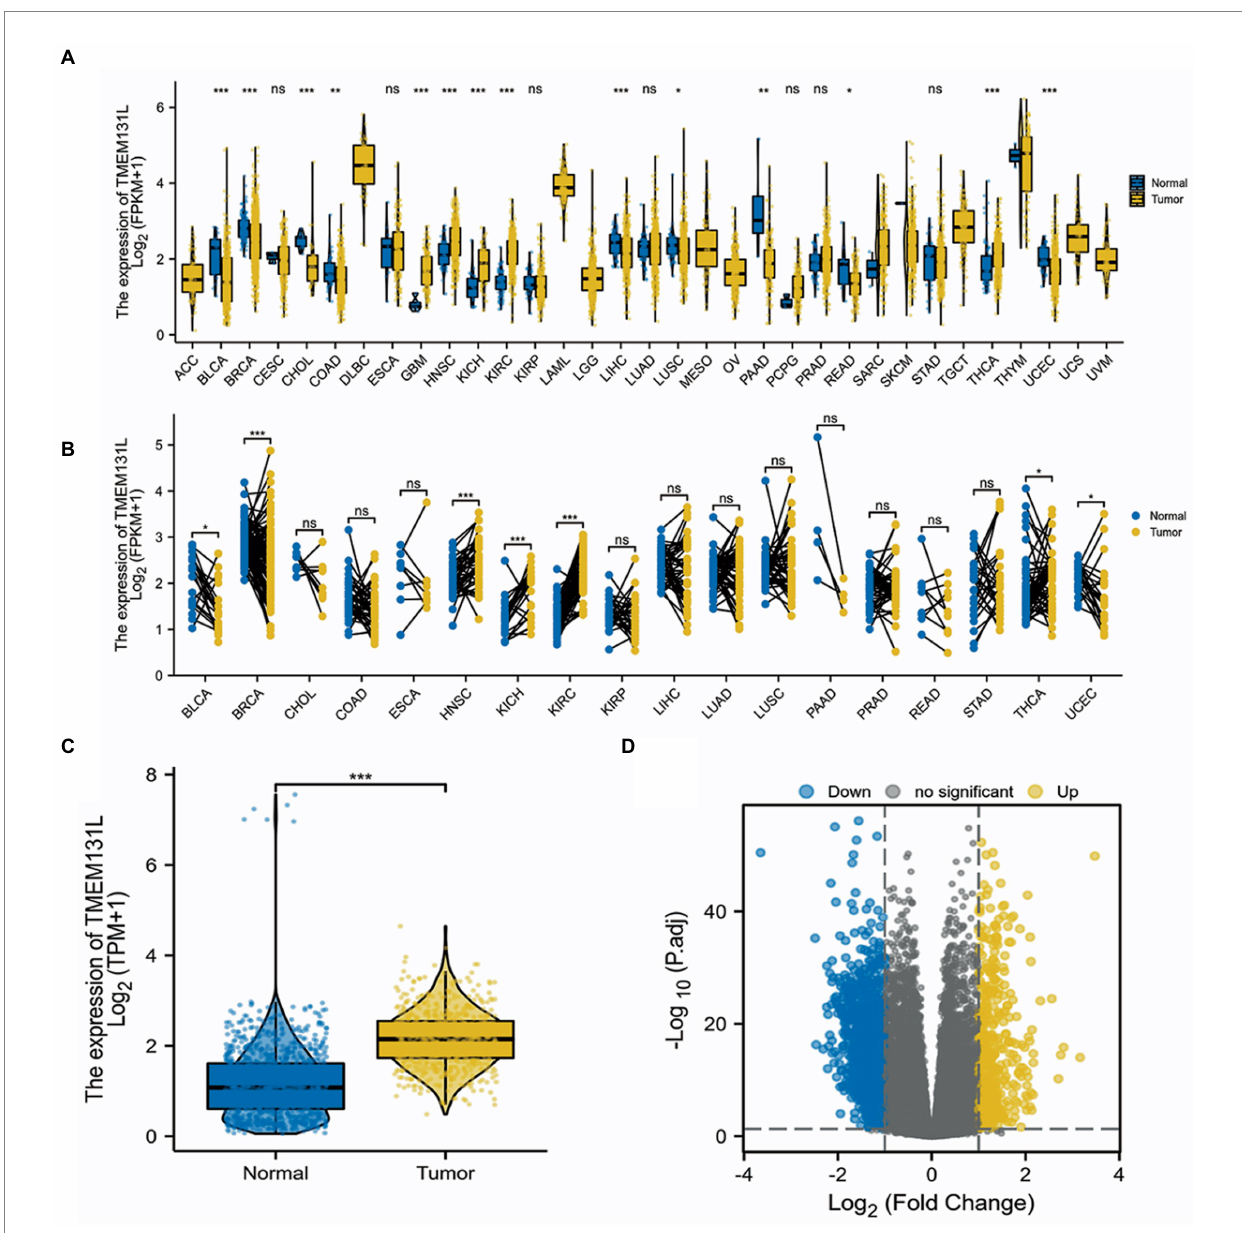
FIGURE 2 Differences in pan-carcinoma expression of TMEM131L. (A,B) Expression difference of TMEM131L in non-tumor tissues and unpaired and paired samples in the TCGA and GTEx pan-carcinoma database; (C) Expression difference of TMEM131L in TCGA and GTEx GBMLGG cohort; (D) Volcanic map of TMEM131L coexpression gene differences in TCGA and GTEx GBMLGG